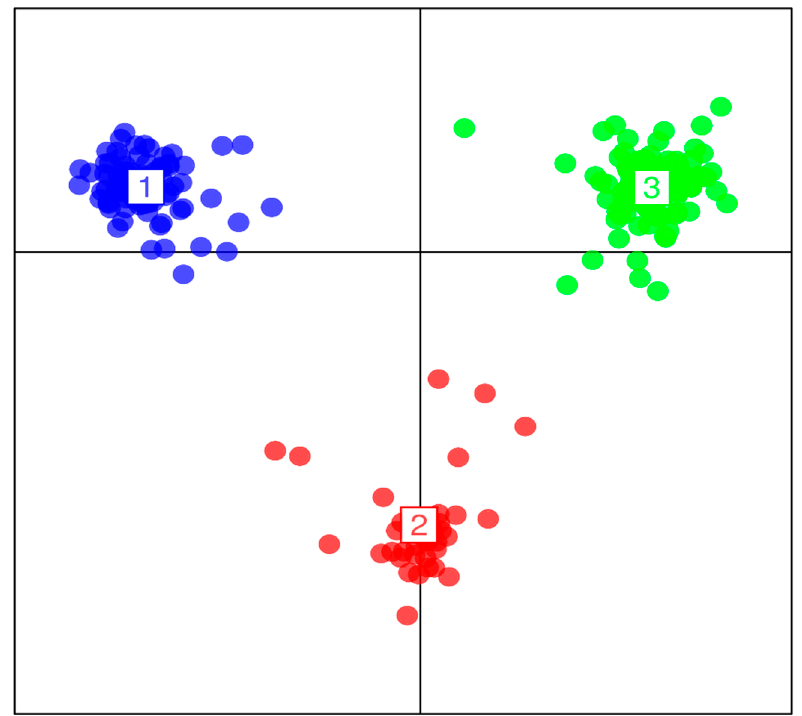
Figure 3. Discriminant analysis of principal components (DAPC) using 5974 DArTseq markers. The axes represent the first two linear discriminants (LD). Each color represents a cluster, while each dot represents an individual. Numbers represent the different subpopulations identified by DAPC analysis.